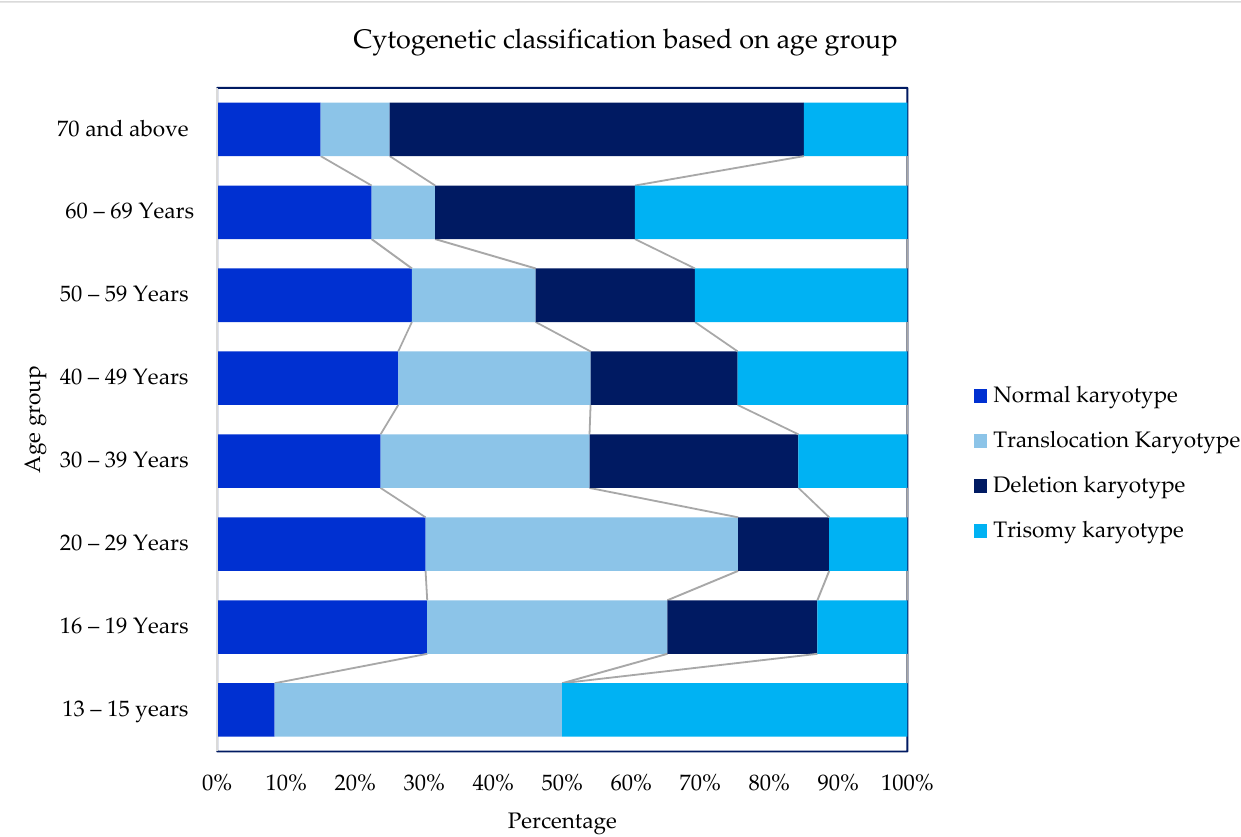
Figure 3. Cytogenetic profiles based on ethnicity. Cytogenetics were successfully performed in 90.9% (601/661) of the cases, as outlined in Table 2. Using Moorman’s classification [21], 294 (49%) of AML patients had a normal karyotype, 214 (36%) had a translocation, 60 (10%) had a deletion, and 33 (5%) had a tri- somy [16]. In terms of the gender distribution of AML cases, there were slightly more males than females with a sex ratio (M: F) of 1.08 overall and 1.07 among the 601 cases with successful cytogenetics in our cohort. The Moorman clustering of four main groups